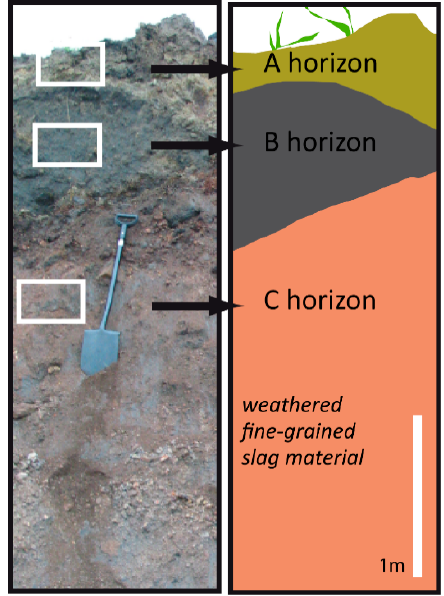
Figure 1. The sampling site showing three different horizons in the uppermost weathered zone of the slag heap labelled as A, B and C.